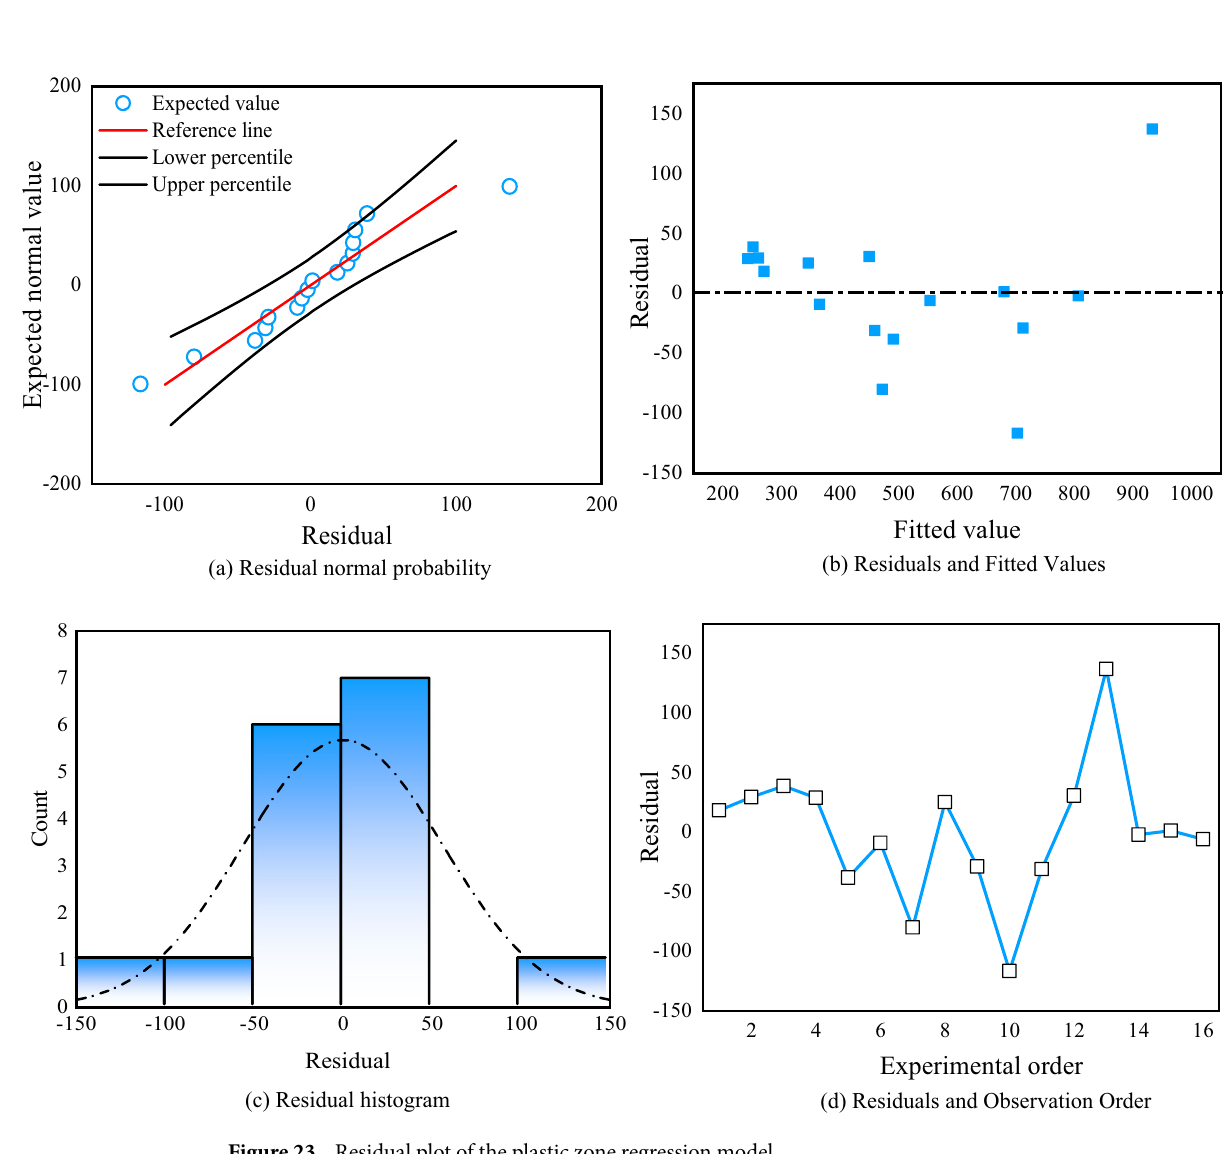
Figure 23. Residual plot of the plastic zone regression